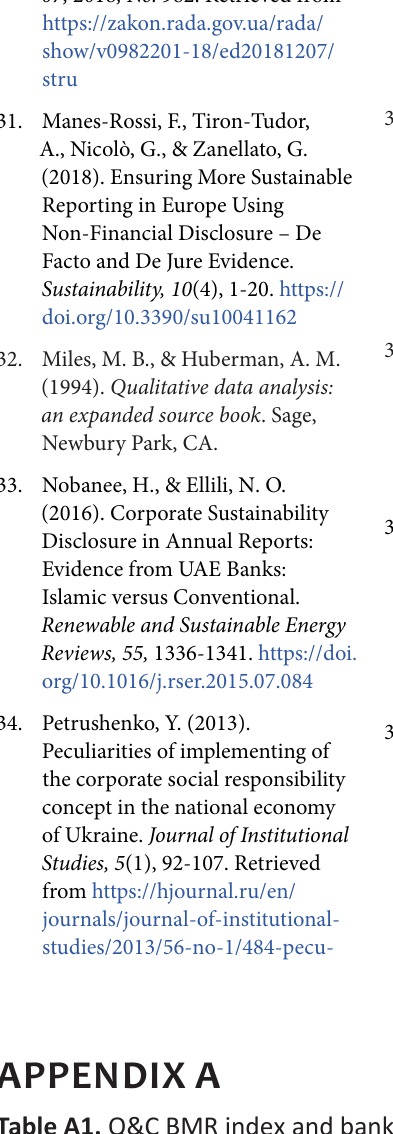
Table A1. Q&C BMR index and bank rating in 2018